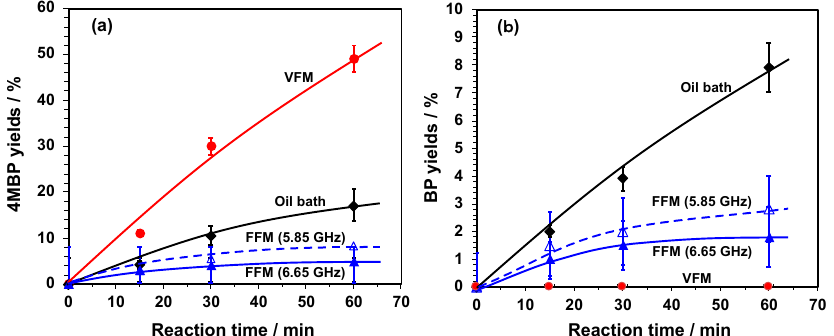
Figure 1. Product yields of ( a ) 4-methylbiphenyl (4MBP) and ( b ) biphenyl (BP) as a by-product in toluene / 1-hexanol solvent under irradiation using fixed frequency microwaves (FFM) at 5.85 or 6.65 GHz, and with variable frequency microwaves (VFM) at 5.85–6.65 GHz, and oil bath heating. Table 1. Chemical yields in the formation of 4-methylbiphenyl (4MBP) and biphenyl (BP) via the Suzuki–Miyamura cross-coupling and homo-coupling process, respectively. Heating Methodology Reaction Time, min